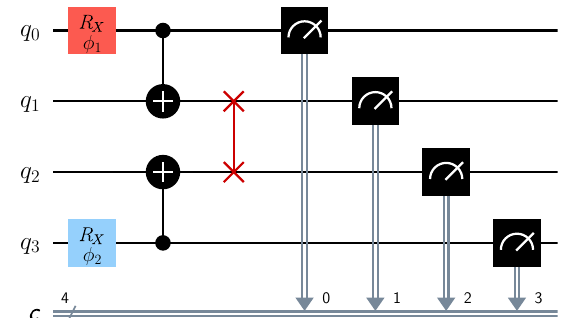
FIG. 7. Quantum-circuit implementation of the SWAP quantum heat engine. The main qubits q 1 , q 2 are first prepared in thermal states at different temperatures with the aid of their ancillas q 0 , q 3 and then undergo a SWAP evolution. Finally, their initial states are read off the ancillas, and their final states are read